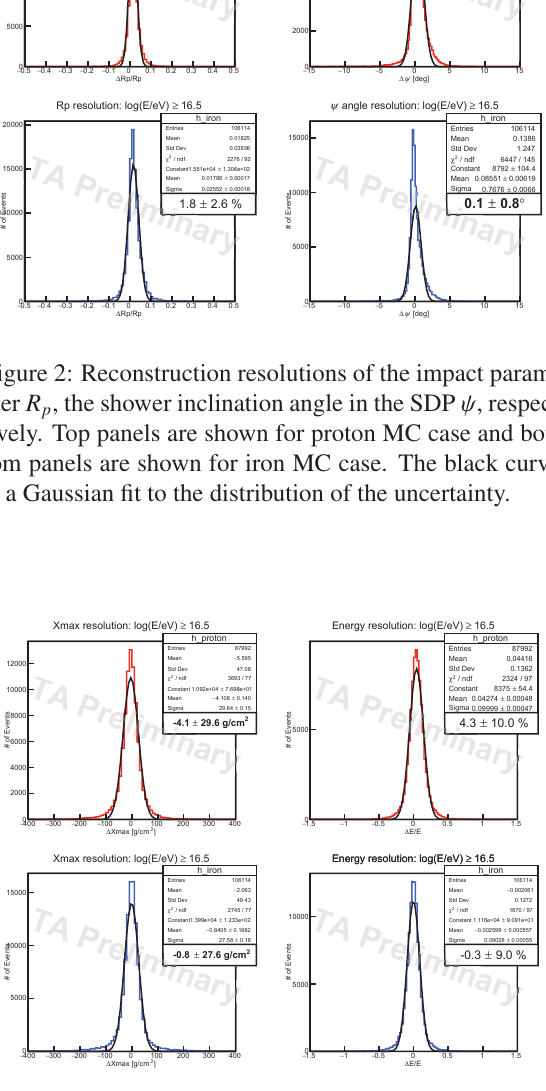
Figure 3: Reconstruction resolutions of the shower max- imum X max , and the shower energy E , respectively. Top panels are shown for proton MC case and bottom panels are shown for iron MC case. The black curve is a Gaus- sian fit to the distribution of the